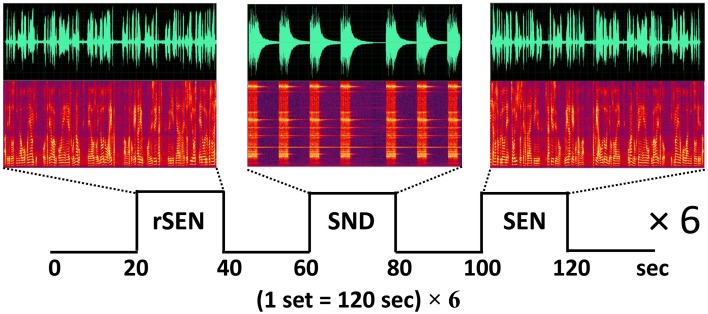
Protocol of fMRI experiment. The subjects passively listened to reverse sentences (rSEN), identifiable non-vocal sounds (SND), and sentences (SEN) during MRI scanning. The top row shows the time-domain waveforms, the horizontal axis shows the tone domain, and the vertical axis shows the power of the sound. The middle row shows the sound spectrograms under the three sound conditions. The horizontal axis shows the time domain, and the vertical axis shows the frequency (about 0–4000 Hz) of the tone domain.